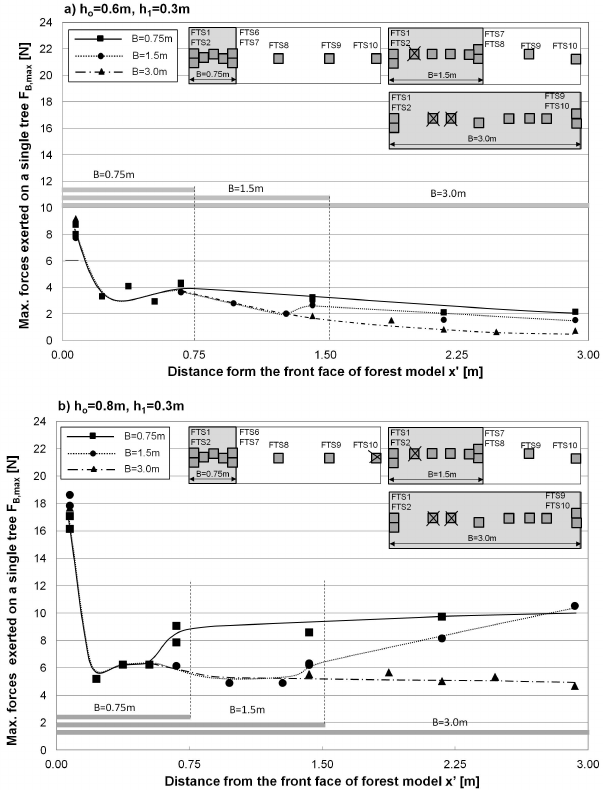
Fig. 12. Selected envelopes of forces exerted by tsunami bores on single mangrove tree models: (a) in case of water depth behind bore gate h o = 0.6m and water depth in front of bore gate h 1 = 0.3m, (b) in case of water depth behind bore gate h o = 0.8m and water depth in front of bore gate h 1 = 0.3m (see Fig. 6 and Table 3 for force transducer